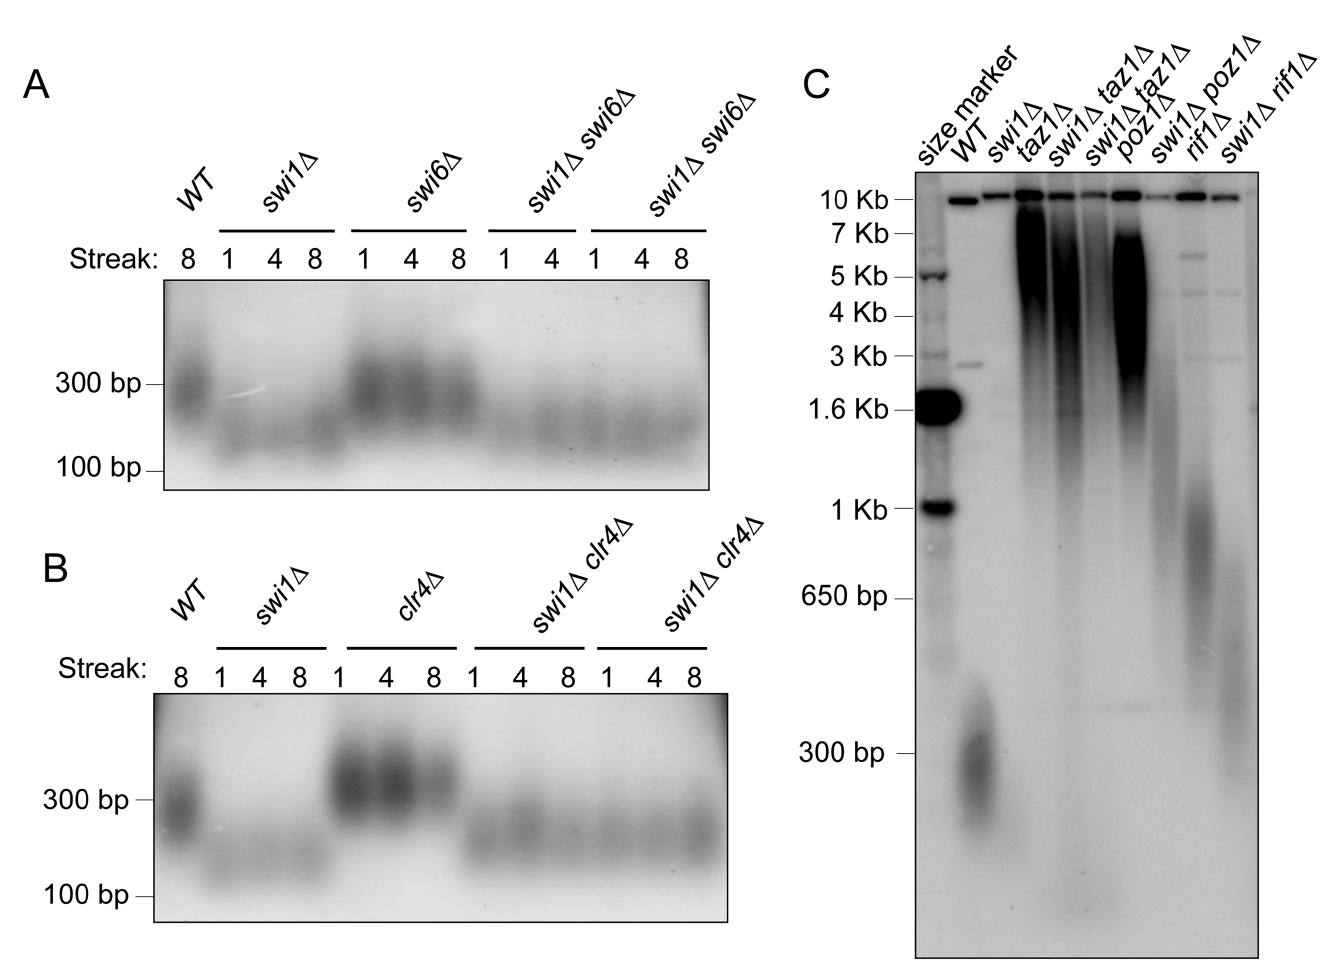
Fig 5. Neither heterochromatin disruption nor shelterin removal can rescue telomere shortening in swi1 Δ cells. (A-B) Loss of heterochromatin- related proteins does not rescue telomere-shortening phenotype of swi1 Δ cells. Southern blot analysis of telomere fragments from the indicated mutants. At least two independent segregants of the double deletion mutants were examined. Genomic DNA was prepared after 1, 4, or 8 restreaks after the indicated strains were generated. Apa I-telomere fragments were detected using a telomere-specific probe as described in Fig 2B. (C) Telomere shortening still occurs in the absence of shelterin components when swi1 is deleted. Cells with the indicated genotypes were passaged at least 8 times and subjected to Southern blot analysis as described in Fig 2B.